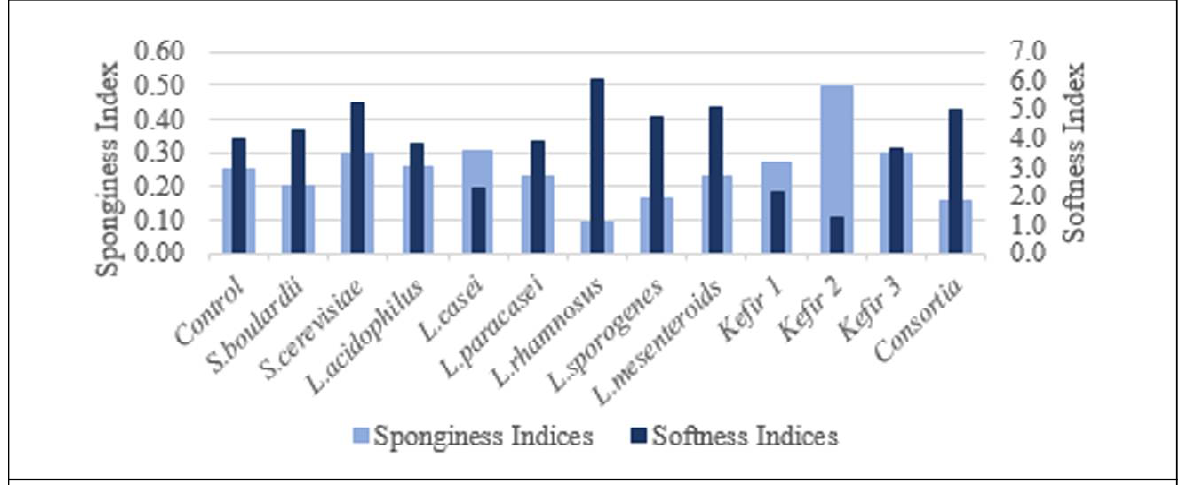
Graph 2: Texture attributes by different